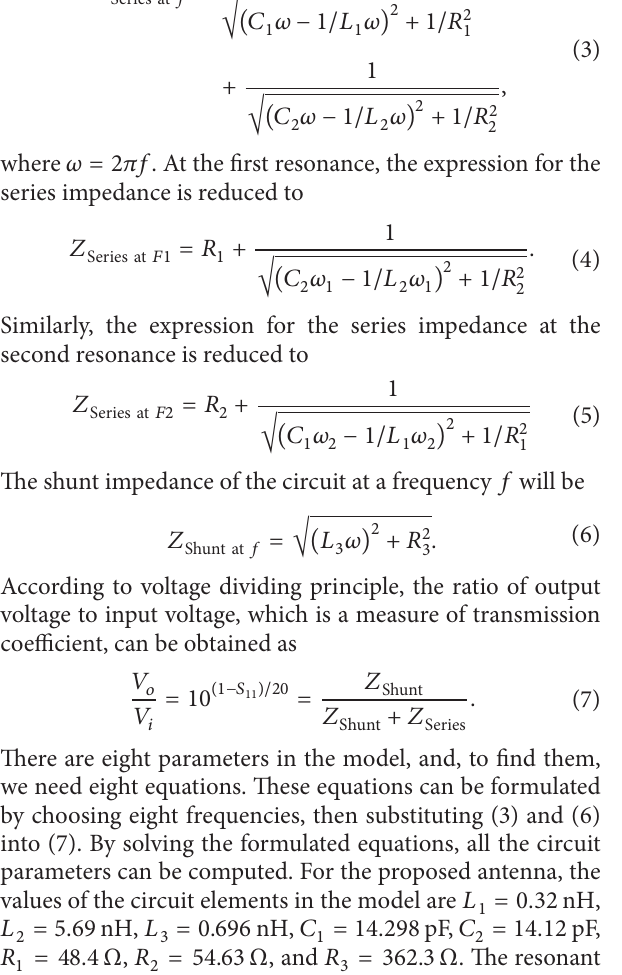
Figure 14: Comparison between the measured reflection coefficient and that produced by the equivalent circuit model of the proposed